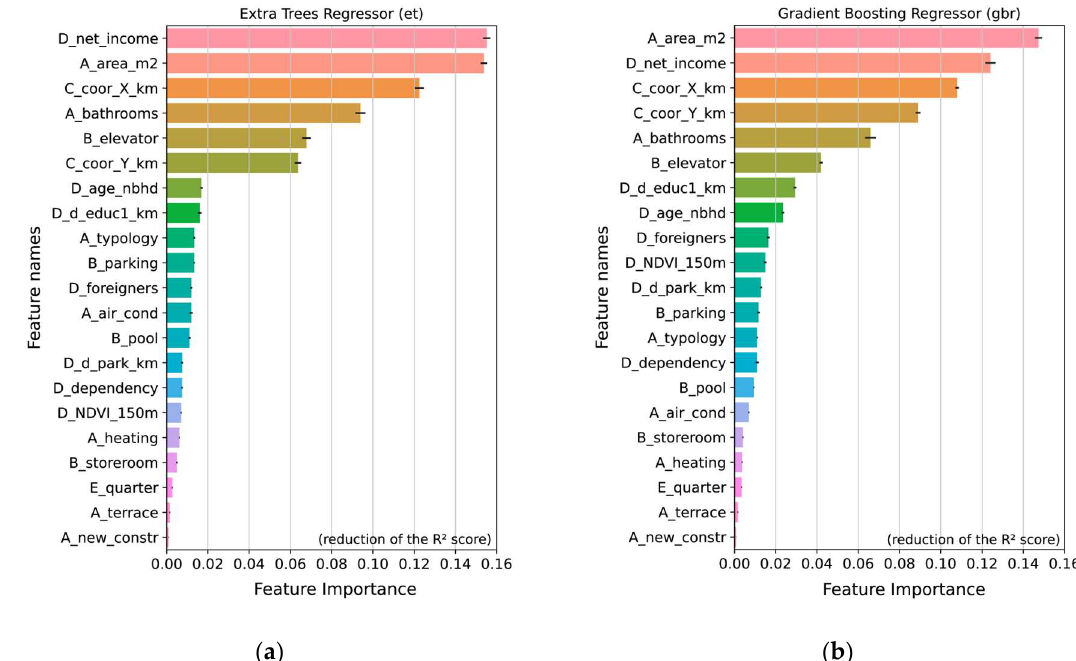
Figure 15. Relative importance of the most relevant features according to the ( a ) Extra Trees Re- gressor algorithm ( et ); and ( b ) the Gradient Boosting Regressor algorithm ( gbr ). algorithm ( et ); and ( b ) the Gradient Boosting Regressor algorithm ( gbr